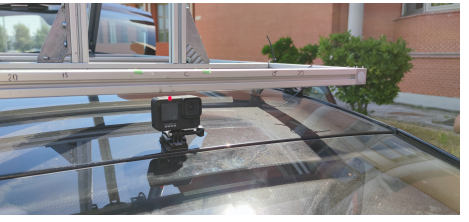
Figure 2. Our vehicle with the attached consumer action